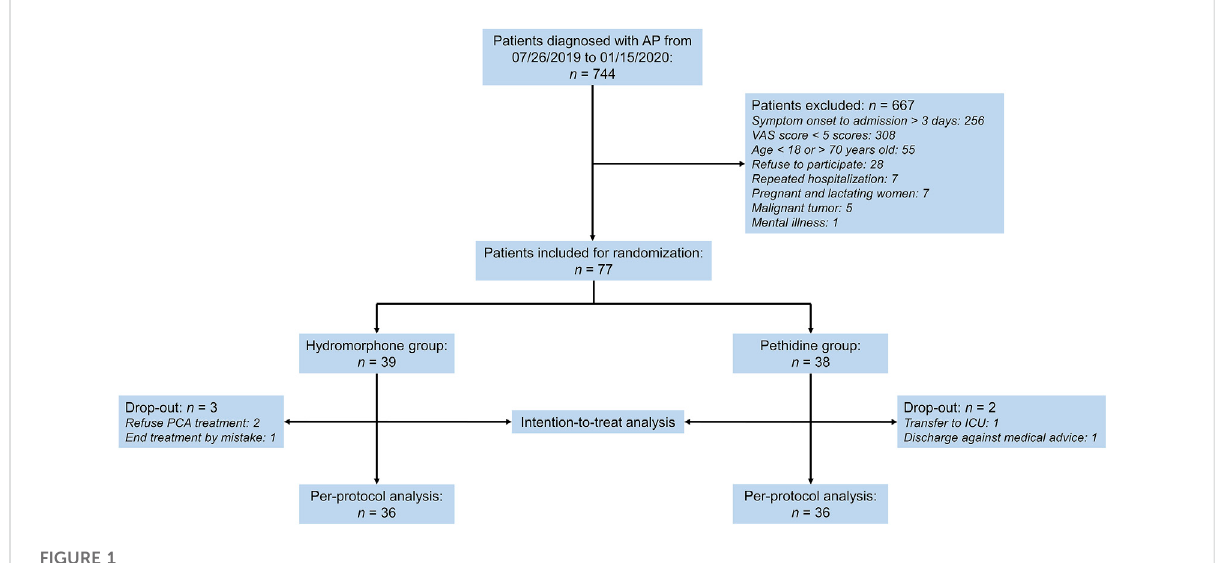
FIGURE 1 Patient selection fl owchart. AP, acute pancreatitis, VAS, visual analog scale score, PCA, patient-controlled analgesia, ICU, intensive care unit.